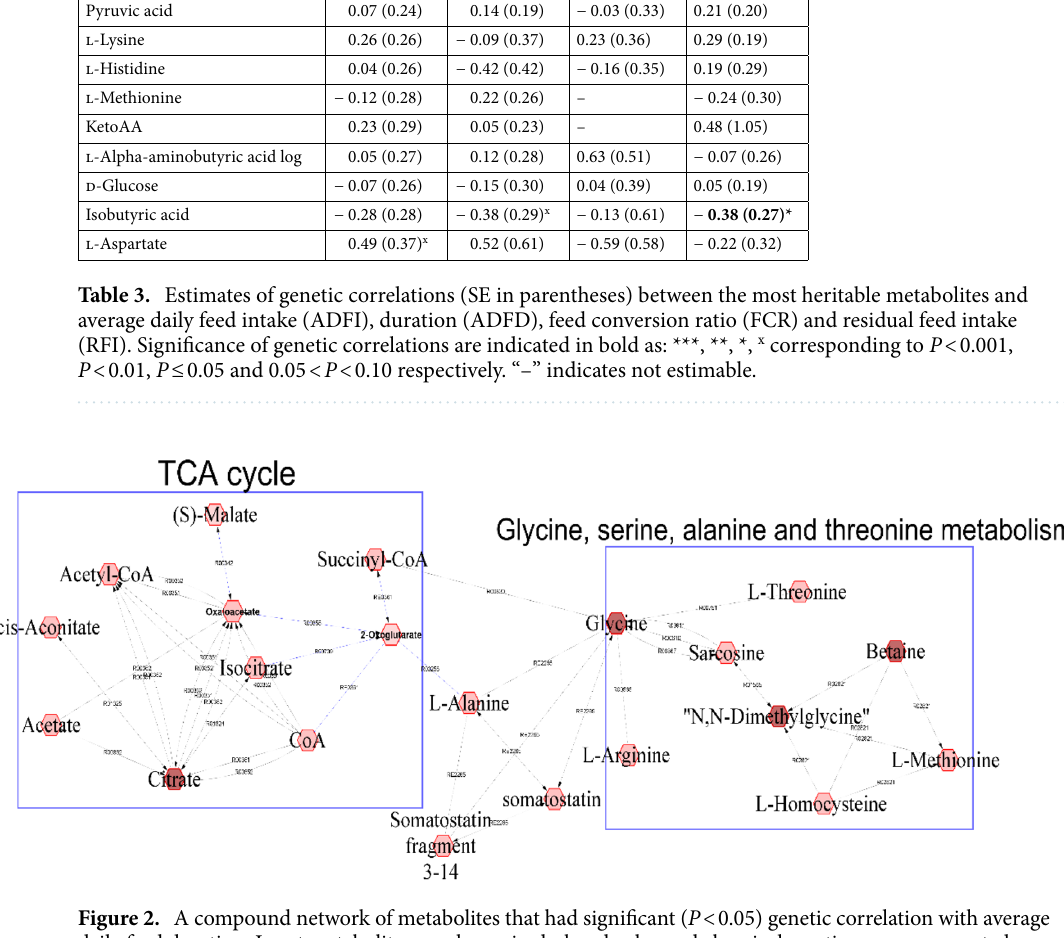
Figure 2. A compound network of metabolites that had significant ( P < 0.05) genetic correlation with average daily feed duration. Input metabolites are shown in dark red color and chemical reactions are represented as